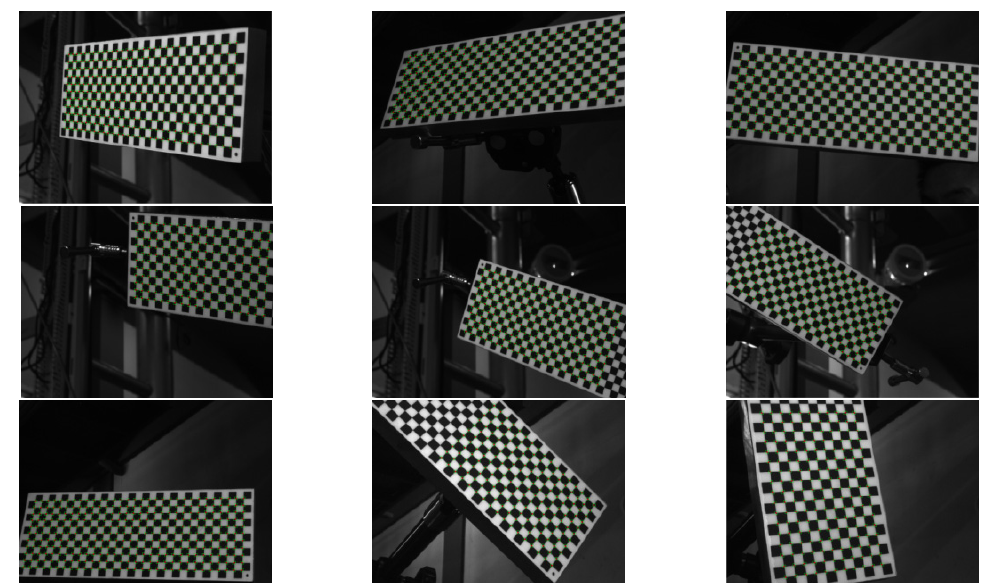
Figure 12. Images used for calibration in the second experiment.